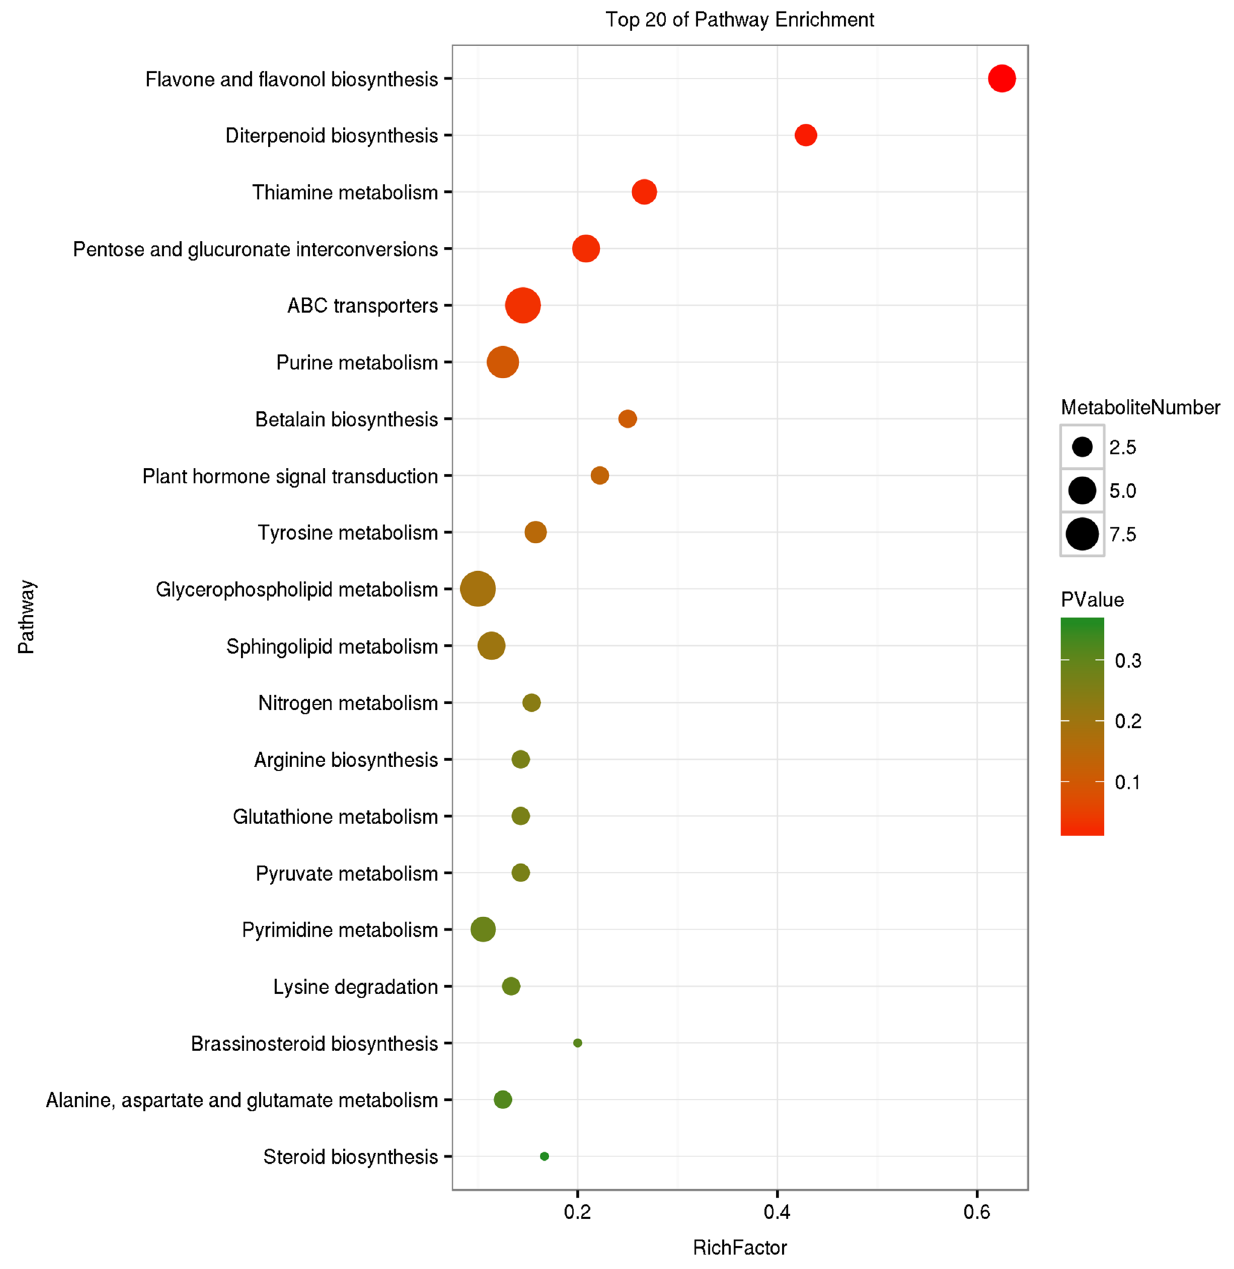
Figure 4. KEGG enrichment map of differential metabolite of two strains at 51 d culture. The vertical axis represents pathway entries, and Rich Factor on the horizontal axis refers to the ratio of the number of differential metabolites in the pathway to the total number of metabolites in the pathway. Higher Rich Factor values indicate a higher degree of enrichment. The size of the circle corresponds to the number of enriched metabolites, with a larger circle indicating more genes. P values range from 0 to 1, corresponding to the gradual change from red to green, with red being zero and indicating more significant enrichment. The figure is plotted with the first 20 pathways of P values from smallest to